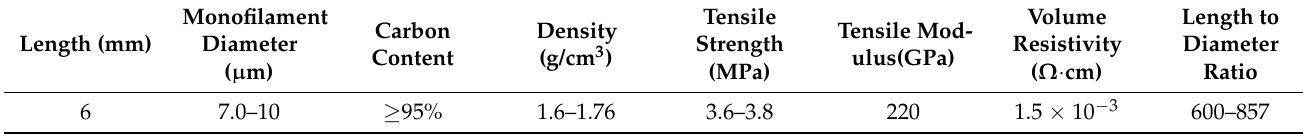
Table 2. Performance parameters of PAN-based carbon